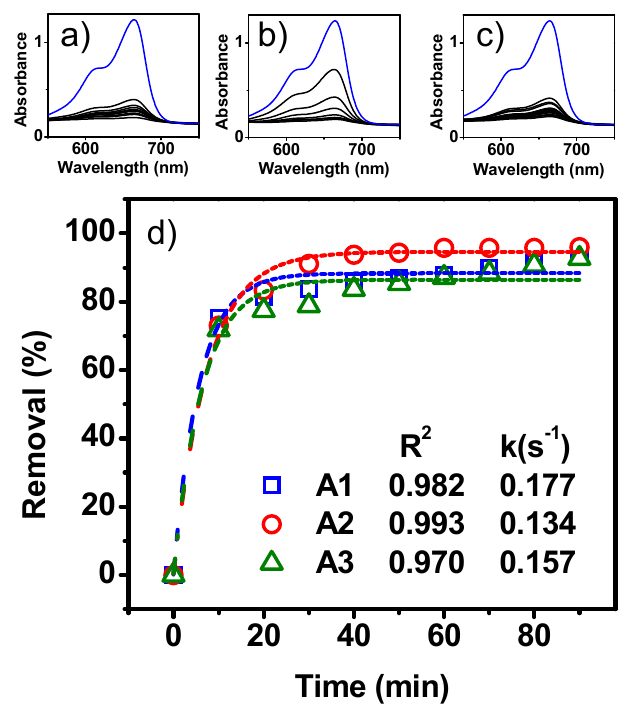
Figure 7. Evaluation of filter diameter in methylene blue removal: ( a , b , c ) UV-Vis spectra when using A1 = 1.27 cm (0.5 inches), A2 = 2.54 cm (1 inch) and A3 = 3.81 cm (1.5 inches) diameter filters, respectively. ( d ) Removal speed curves for each condition.